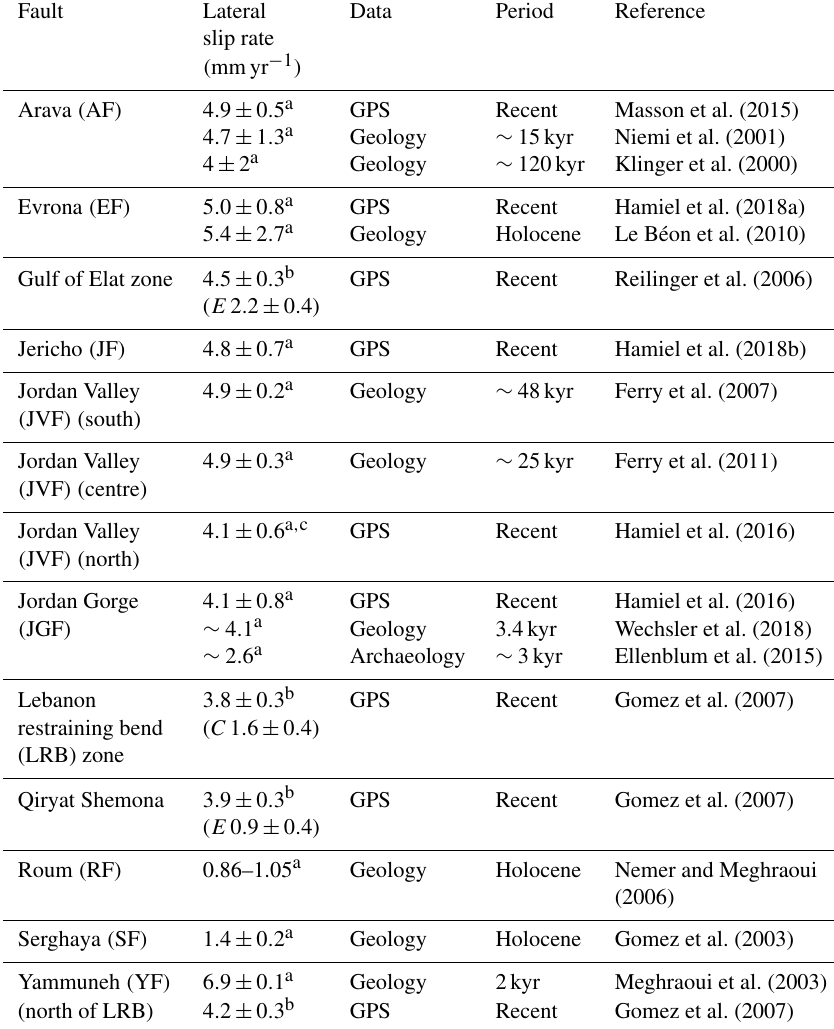
Table 1. Main strike-slip faults: average slip rate